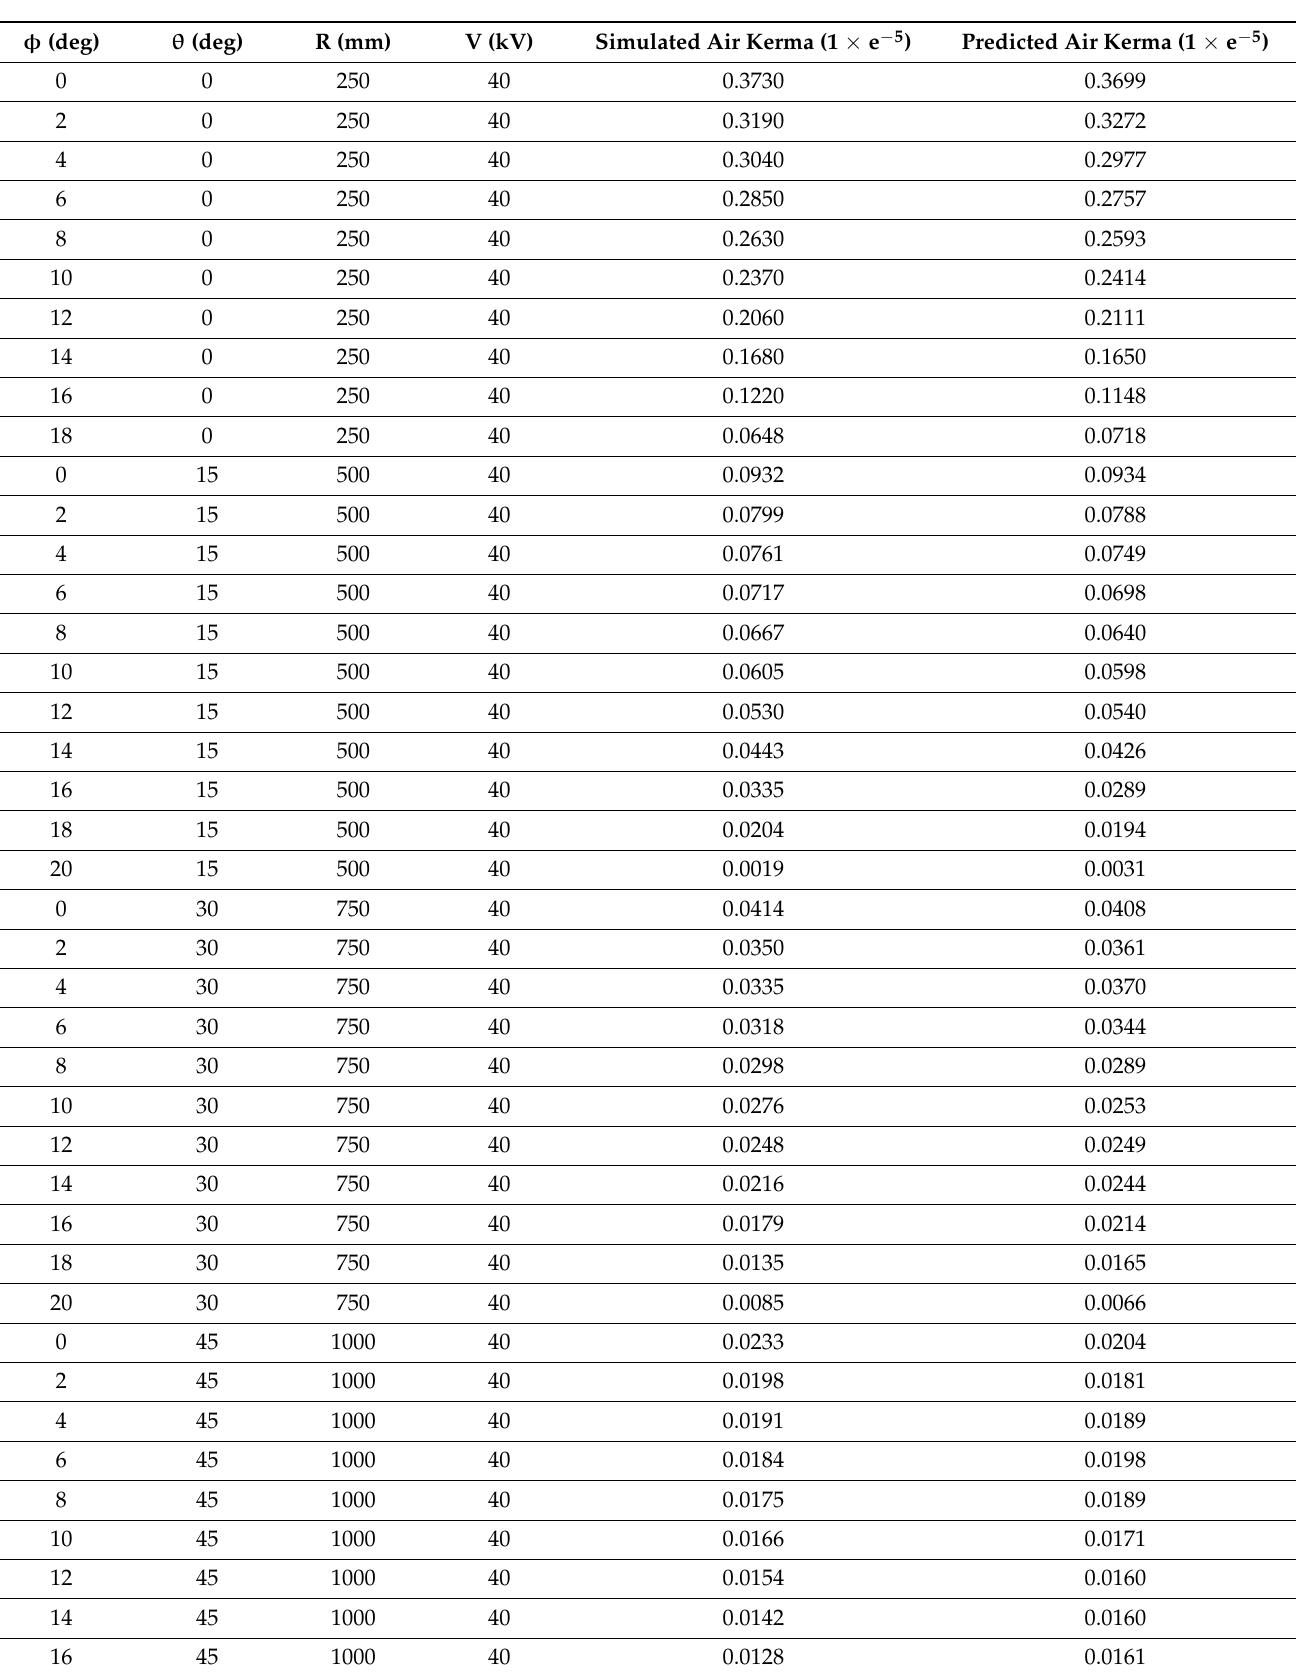
Table 1. Some input and output data of the GMDH neural